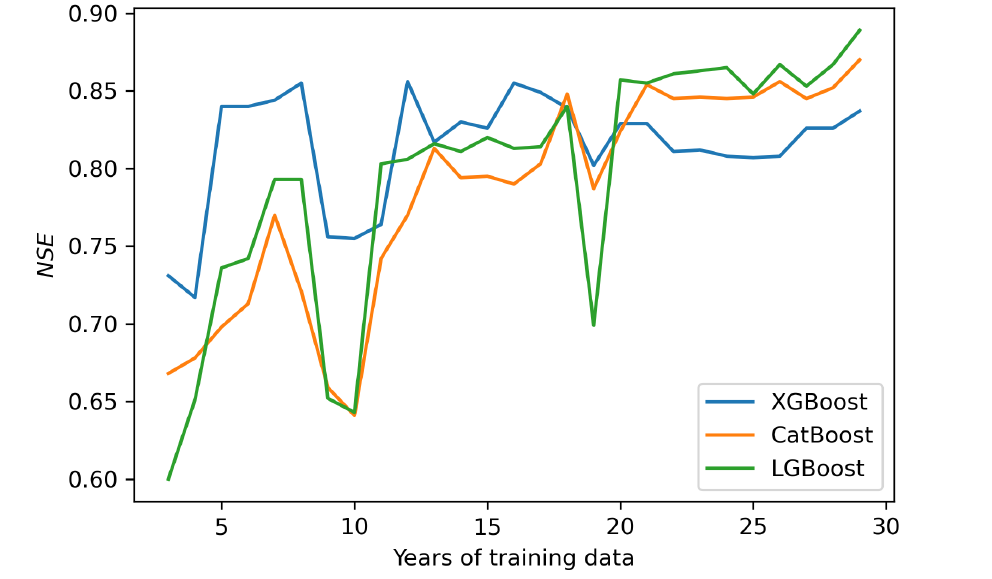
Figure 13. Nash-Sutcliffe model efficiency as function of training dataset legth (years of daily